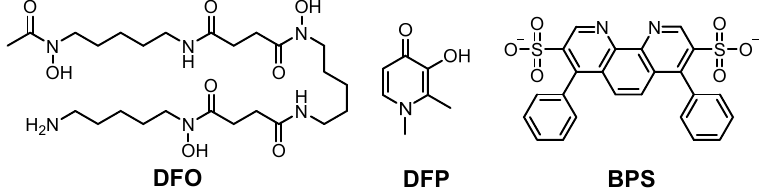
Figure 4. Representatives of Fe(II/III)-targeting molecules. Left: deferoxamine ( DFO ), N 1 -(5-aminopentyl)- N 1 -hydroxy- N 4 -(5-(N-hydroxy-4-((5-(N-hydroxyacetamido)pentyl)amino)-4-oxobutanamido)pentyl)succinamide; middle: deferiprone ( DFP ), 3-hydroxy-1,2-dimethylpyridin-4(1 H )-one; right: bathophenanthroline disulfonate ( BPS ), 4,7-diphenyl-1,10-phenanthroline-3,8-disulfonate. Table 3. Recent animal studies conducted with Fe-targeting chemical agents. Results of in vivo experiments performed with deferoxamine ( DFO ), deferiprone ( DFP ), M30 , and HLA20 are sum- marized.